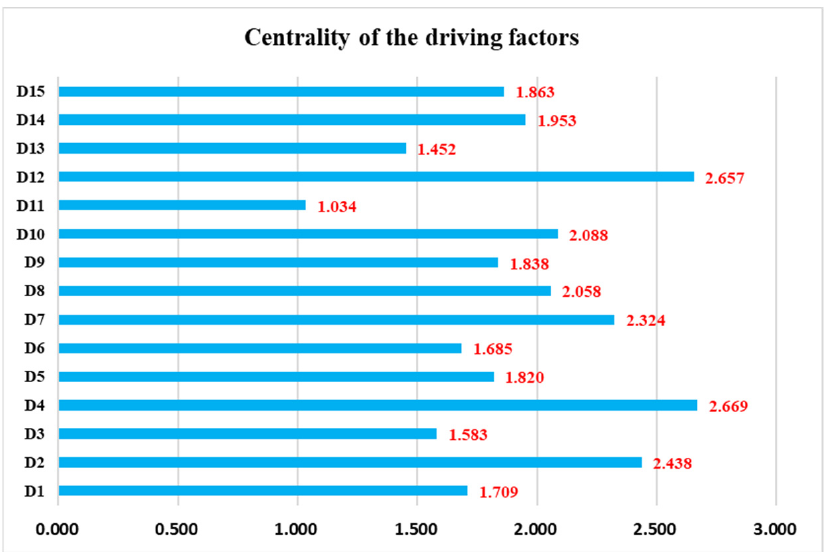
Figure 3. Centrality distribution of driving factors.